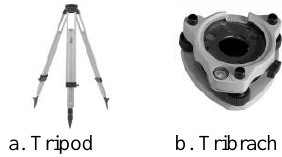
Figure 4. Tripod and